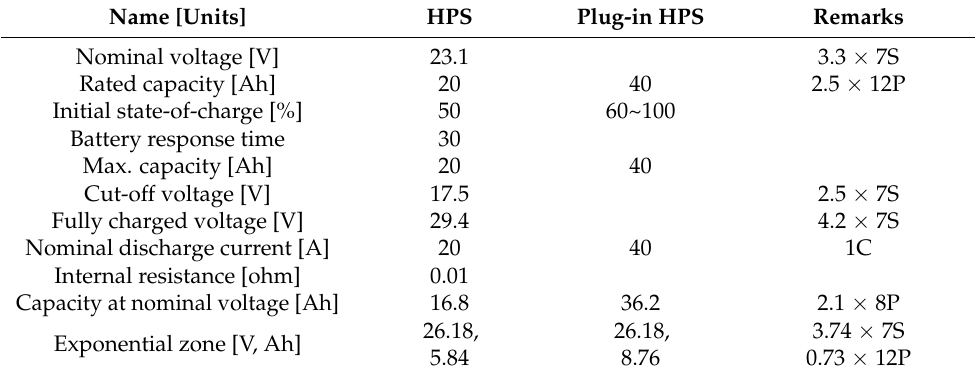
Table 3. Battery model parameters.